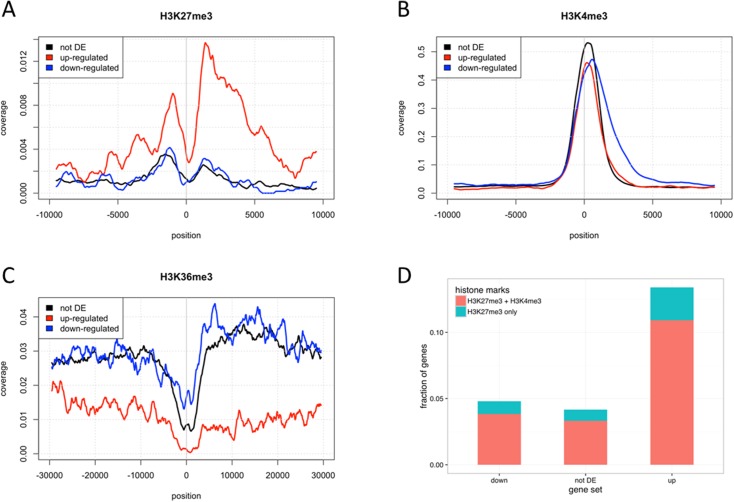
Histone mark distribution with respect to dysregulation status in pre-B cALL.(A) Relative peak coverage of H3K27me3 repressive mark. (B) Relative peak coverage of H3K4me3 activating mark. (C) Relative peak coverage of the H3K36me3 mark associated to active transcription. (D) Fraction of genes with H3K27me3 or both H3K27me3 and H3K4me3 (bivalency) near their TSS (-5kb to +5kb). Genes with an FDR<0.001 and a log2FC > 2 (or < -2) in all subtypes have been classified as up-regulated (or down-regulated). Genes not differentially expressed (not DE) include all genes with FDR>0.5. Only the most upstream TSS of each gene was considered. Histone peak data was obtained from ENCODE epigenome E031 [55].